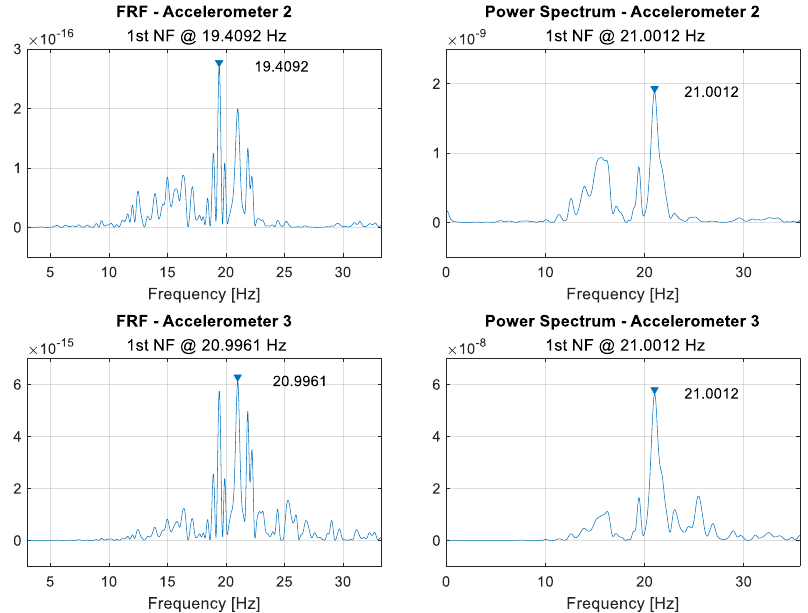
Figure A7. Arduino measurement: 0.25 revolution bolt release.